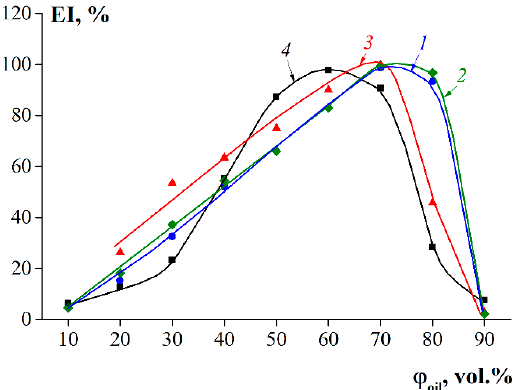
Figure 5. The dependences of emulsion index (EI) on oil volume fractions for emulsions stabilized with fish gelatin, where 1—G1, 2—G2, 3—G3, and 4—G 7041. Gelatin concentration was 4 wt.%.